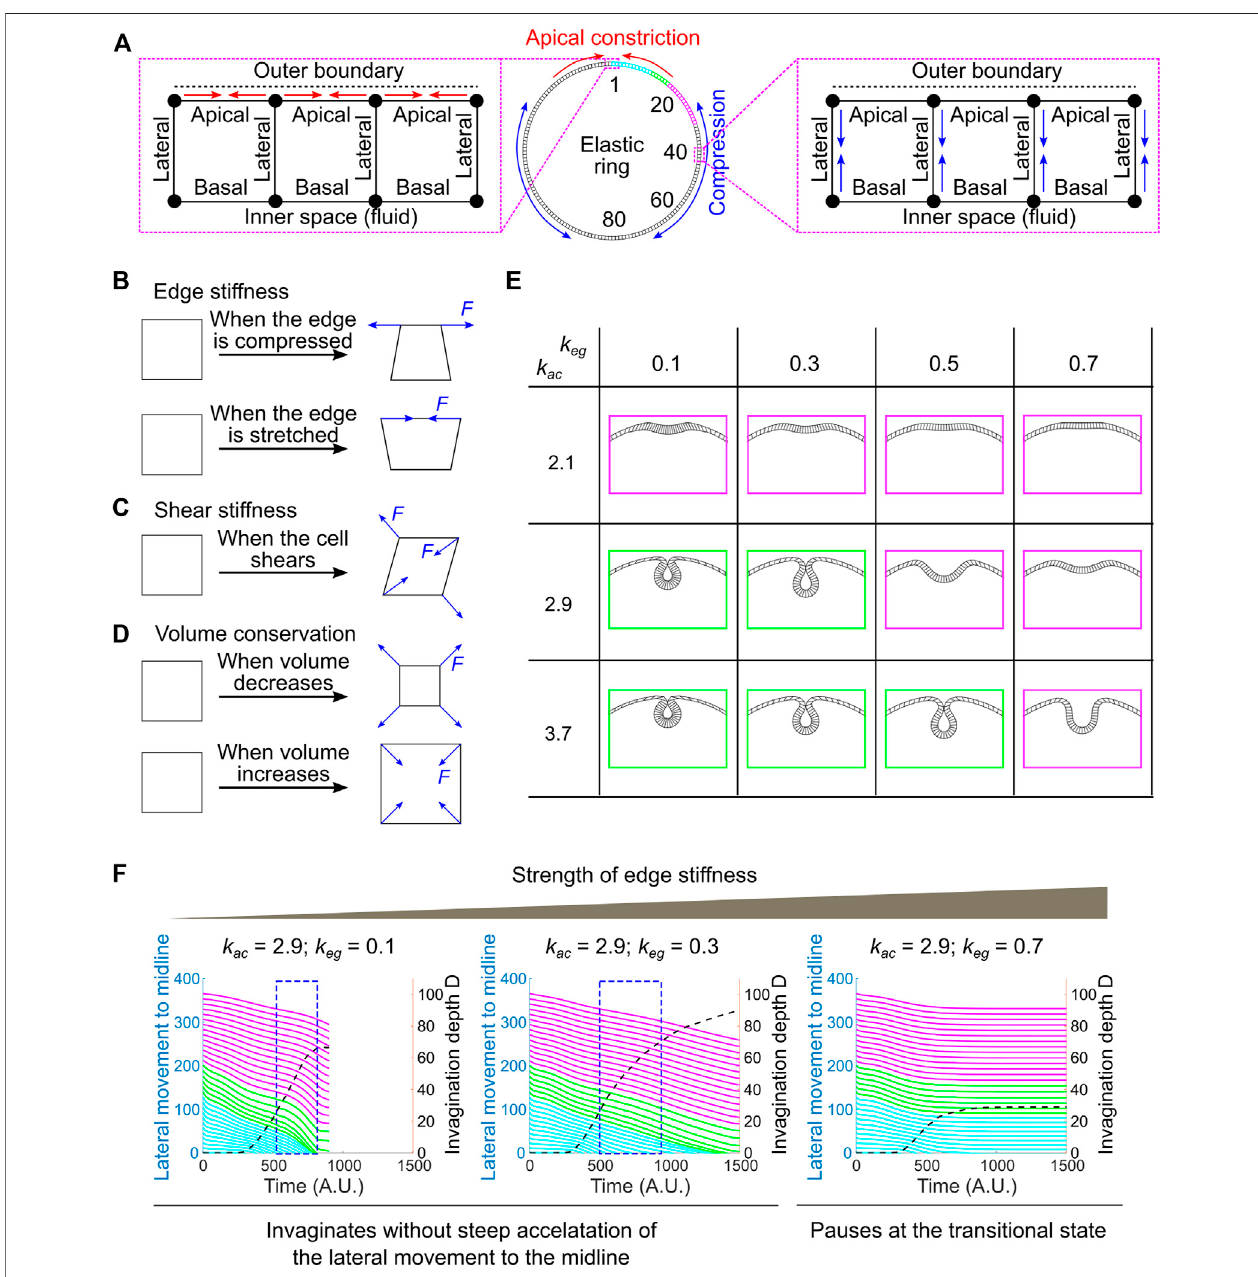
FIGURE 7 | Developing a vertex dynamics model to investigate folding dynamics in a ring-shaped elastic monolayer. (A) Vertex dynamics model simulating the behavior of a ring-shaped elastic monolayer undergoing localized apical constriction in the presence or absence of in-plane compressive stresses. The monolayer is discretized into 160 equal units. The IDs of selected units at the right half of the ring are shown. ID 1 marks the midline of the constricting domain. Colored regions are analyzedfortheirmovementduringthefoldingprocess(panel F ,similartotheventral-lateralregionanalyzedin Figure6D ).Enlargedviews:Left,contractionsofthe apical edges (red arrows) within a designated region of the monolayer results in local apical constriction. Right, shrinking of the lateral edges (blue arrows) outside of the apical constricting domain results in the generation of in-plane compression due to volume conservation. (B – D) Mechanisms that de fi ne the passive mechanical properties of the model. “ F ” denotes restoration forces. (B) Edge stiffness. The apical, lateral and basal edges resist stretching or compression like springs. (C) Shear stiffness. Shear deformation is dampened through the application of shear restoration forces to resist angle changes between intersected edges. (D) Volume conservation. Every unit in the model has a propensity to maintain its volume (cross-section area in 2D) through the implementation of volume restoration forces. (E) Undercertaincombinationsofapicalconstriction ( k ac ) andedgestiffness ( k eg ) ,localapicalconstrictioncantriggerinvaginationofthemonolayerintheabsenceofglobal compression ( k lc = 0). Only the top region of the model is shown. (F) Relationship between invagination depth D (dashed line) and the movement of the lateral non- constricting region ( “ lateral movement, ” solid lines) towards the midline. In the absence of global compression, invagination of the constricting domain (blue box) is no longerassociatedwithasteepaccelerationinthelateralmovement, whichisincontrasttothetightcoupling ofthetwoprocesses inrealembryos( Figure6D ).Thesolid lines are color coded according to the color regime shown in (A) .